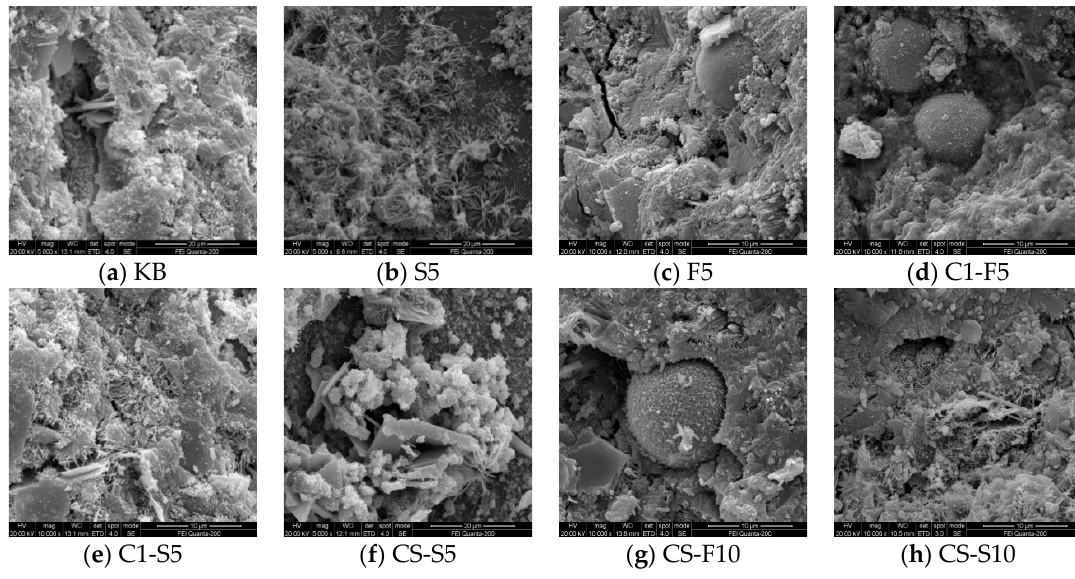
Figure 14. ESEM-EDS spectra of mortar